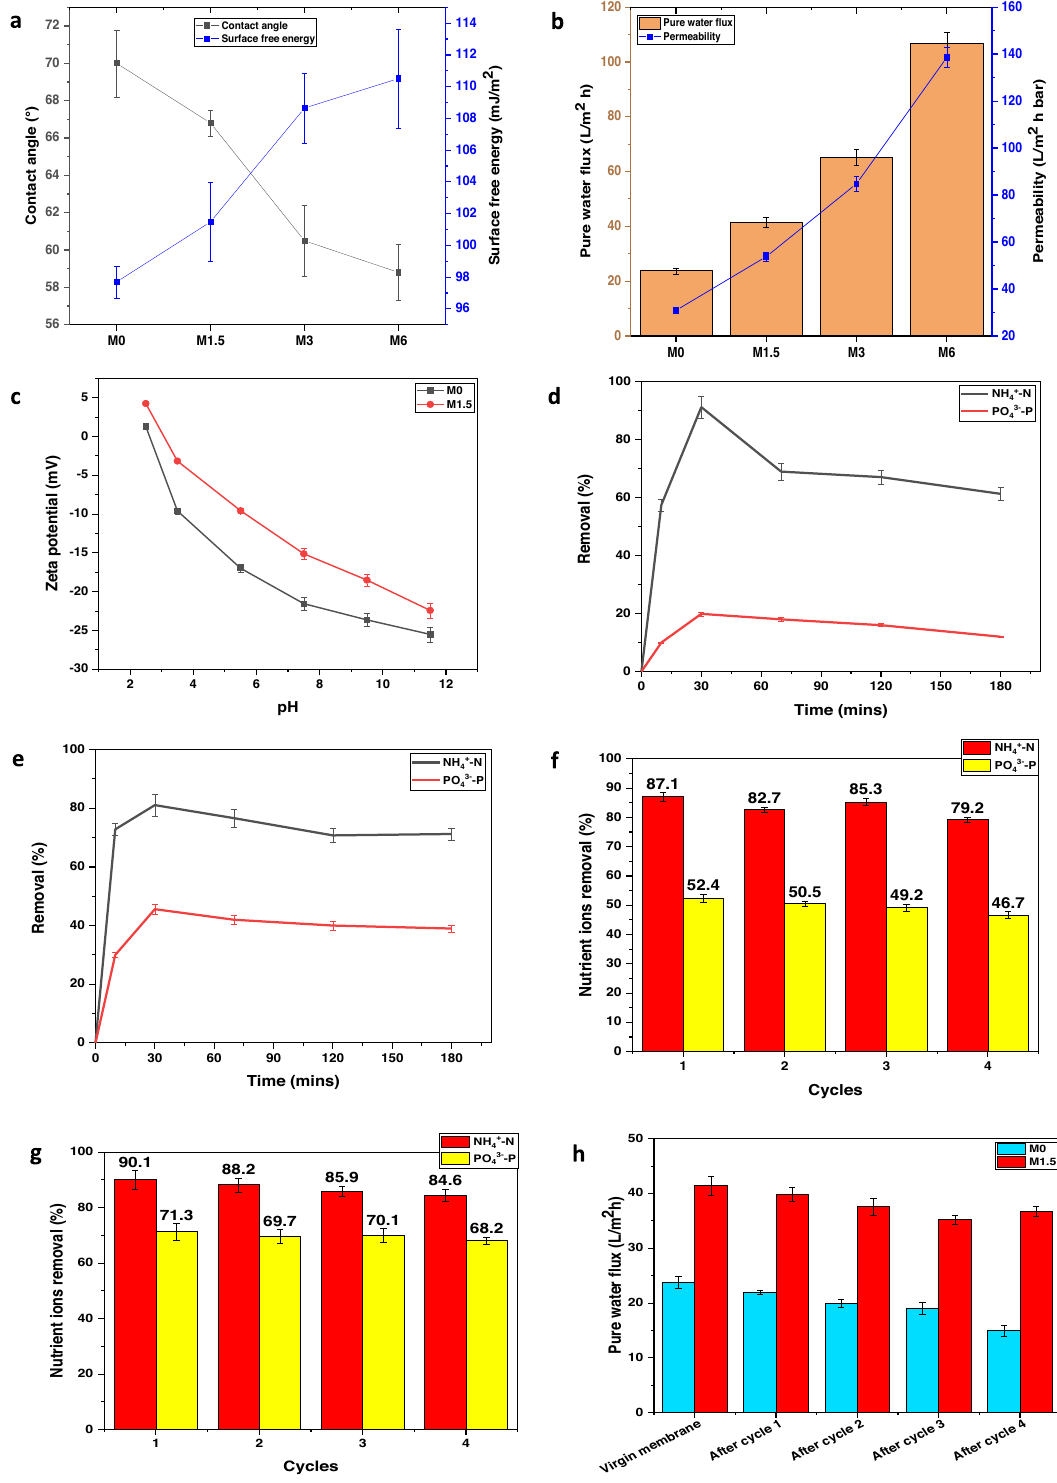
Fig. 3 Performance of membranes. a Static CA and surface free energy of the pristine and nanocomposite membranes. b Pure water fl ux and permeability pro fi les of the pristine and nanocomposite membranes. c Zeta potential of M0 and M1.5 membranes. Nutrient ions removal over 3 h of operation using d the M0 membrane and e the M1.5 membrane. Nutrient ion removal of f M0, g M1.5 membranes, and h pure water fl ux after several raw wastewater fi ltration